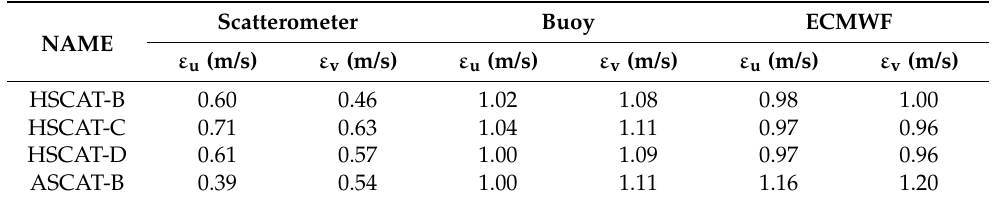
Figure 8. Spectra of the HSCAT-B (red), HSCAT-C (green), HSCAT-D (black), and ASCAT-B (pink) wind and ECMWF background real wind (blue) for ( a ) u-component and ( b ) v-component. Table 4. Standard deviations of errors in the u and v wind components obtained from the ETC of the scatterometer with buoy and ECMWF winds.